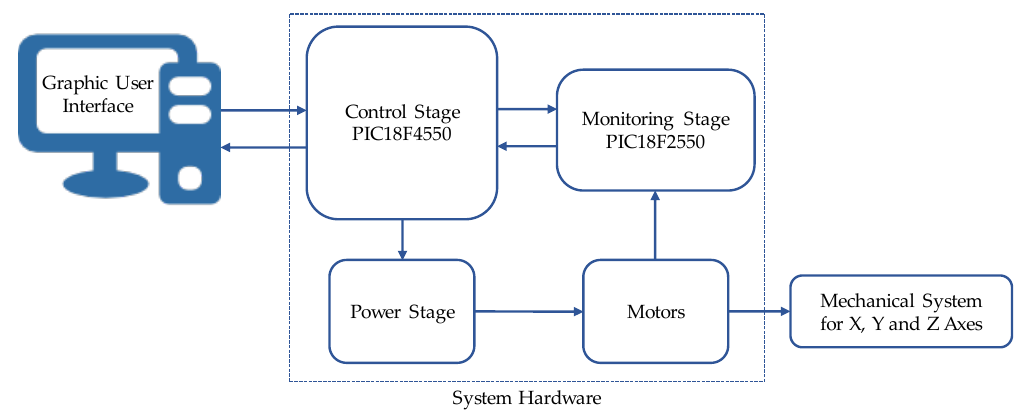
Figure 1. Block diagram of the system.